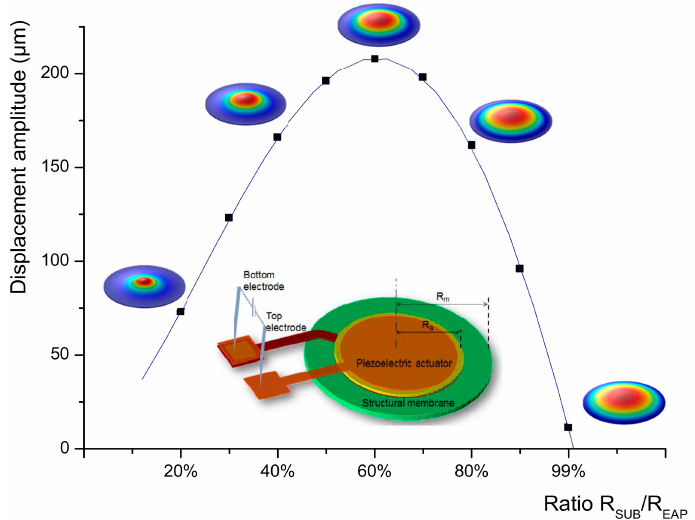
Figure 4. Optimization of the R EAP /R sub ratio to obtain maximal displacement for circular actuator. Sketch of the structural membrane and piezoelectric actuator, simulated in the developed